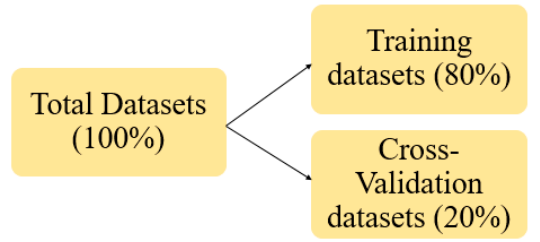
Figure 5. Representation of current database